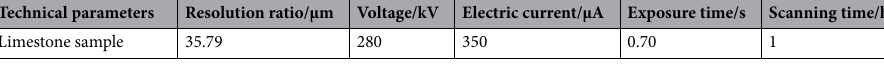
Table 1. Basic test